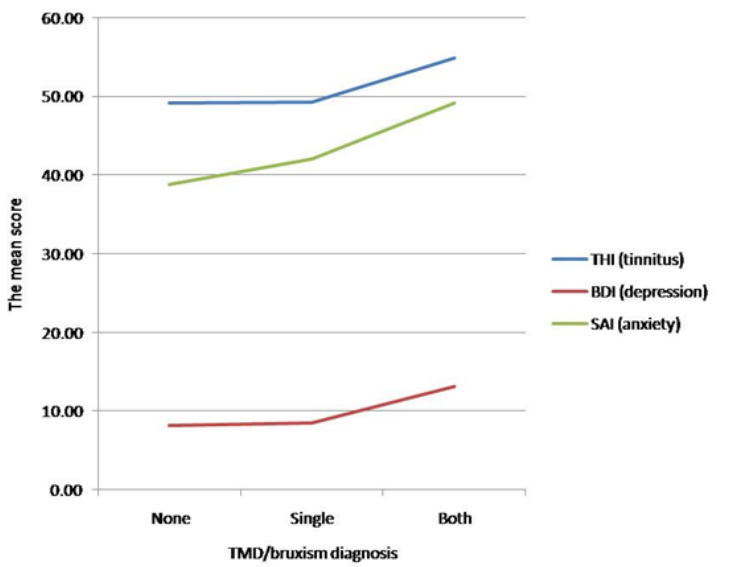
Figure 4. Graphical presentation of the mean THI, BDI and SAI scores in three TMD/bruxism groups.